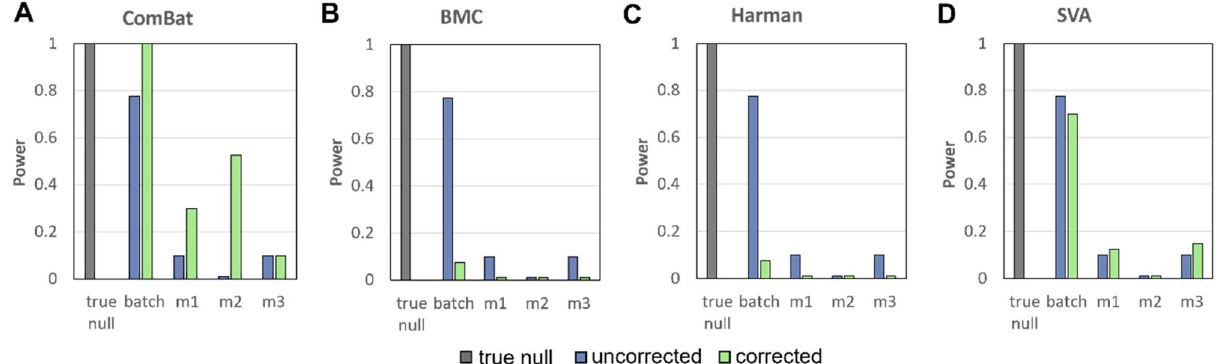
Figure 7. 4 Batch effect correction algorithms (BECAs) are used for evaluation of power for Initial Simulation based on statistical feature selection: ( A ) ComBat ( B ) BMC ( C ) Harman ( D ) SVA. Higher values indicate better performance (higher recall of correct